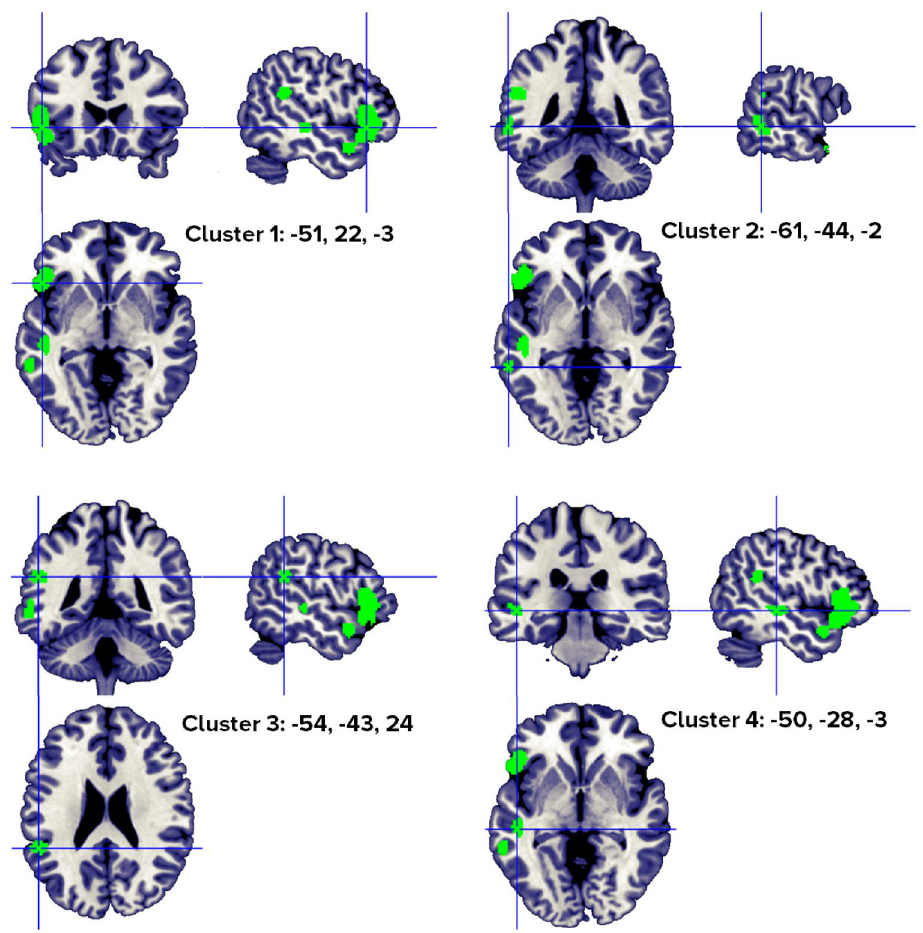
Figure 6. Clusters activated by the abstract > concrete words contrast. The crosses are centered in the areas correspond to stereotactic coordinates reported in Table 6. The images are presented in neurological